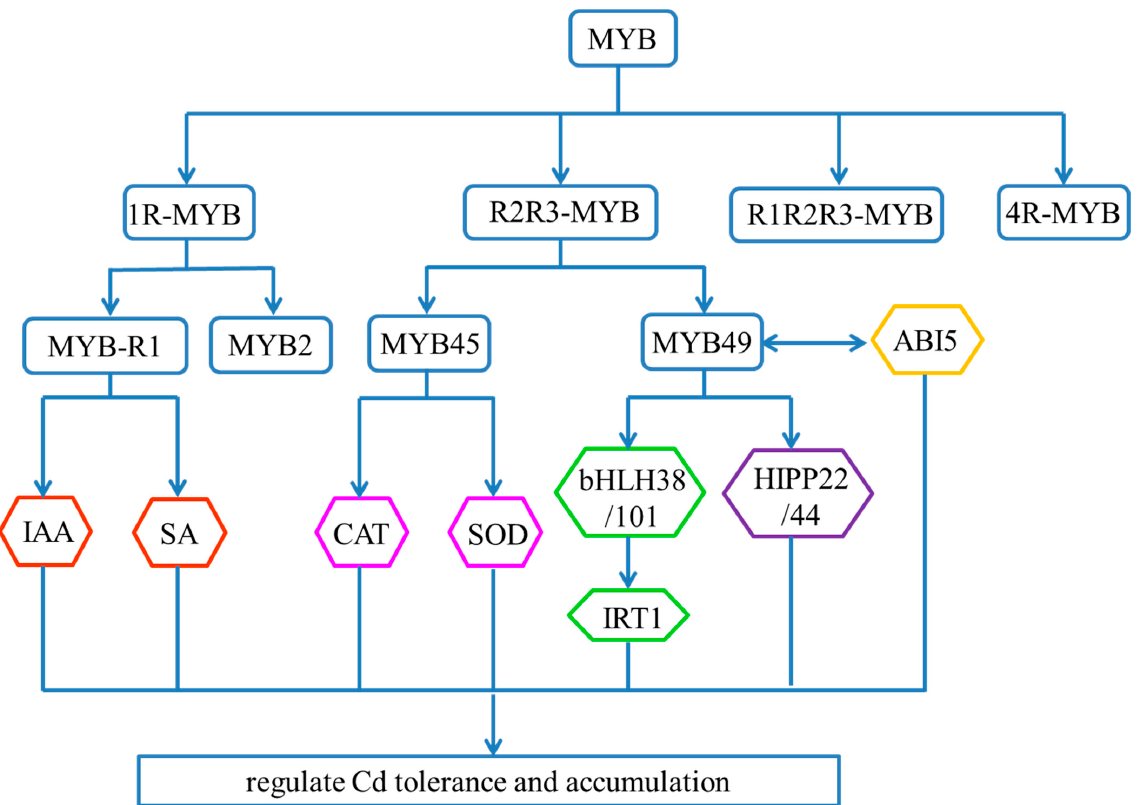
Figure 3. Transcriptional regulatory pathways of MYB TFs. MYB proteins are divided into four categories: 1R-MYB, R2R3-MYB, R1R2R3-MYB, and 4R-MYB. MYB2, as a 1R-type MYB, was